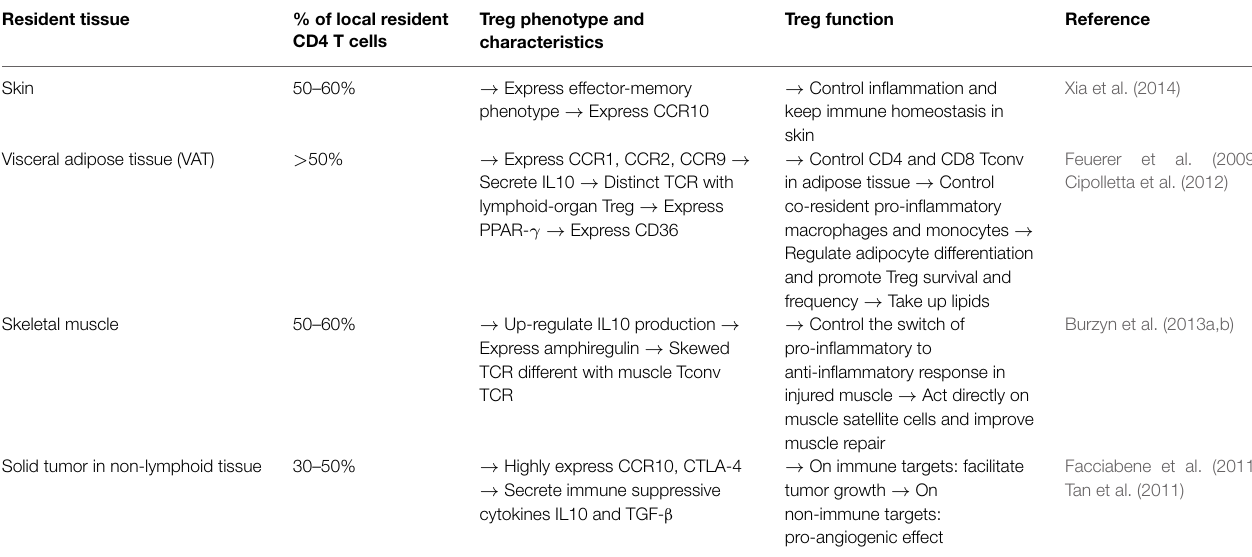
TABLE 1 | Tissue resident Treg express different phenotype and function in different tissues. Resident tissue